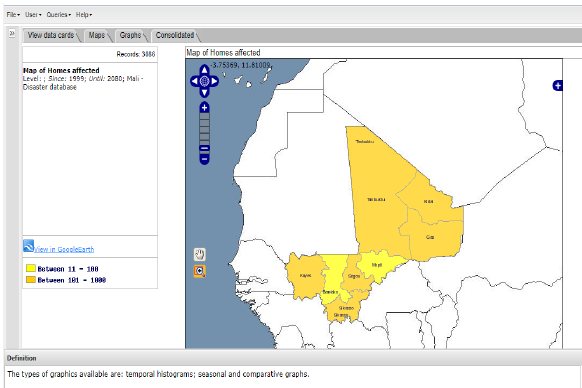
Figure 7. Example of homes affected in a catastrophe.